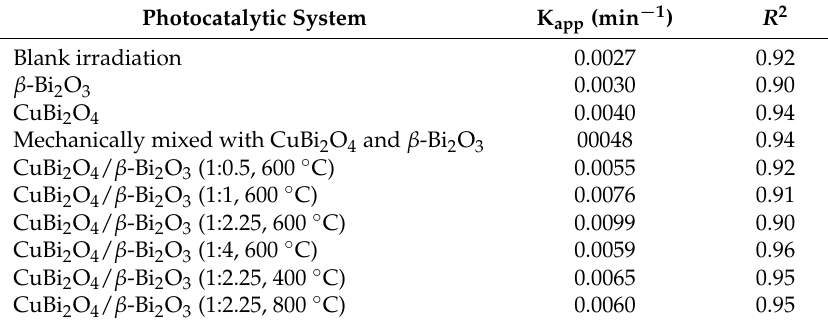
Table 1. Kinetic analysis of DS degradation in different photocatalyst systems. Photocatalytic